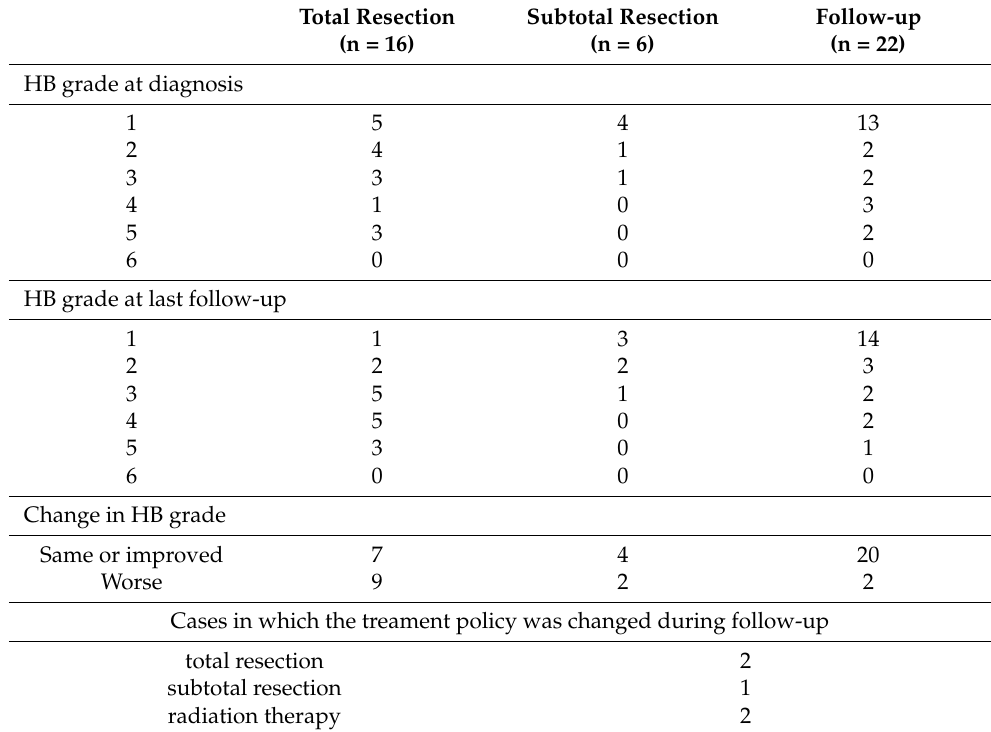
Table 2. Outcomes of each treatment